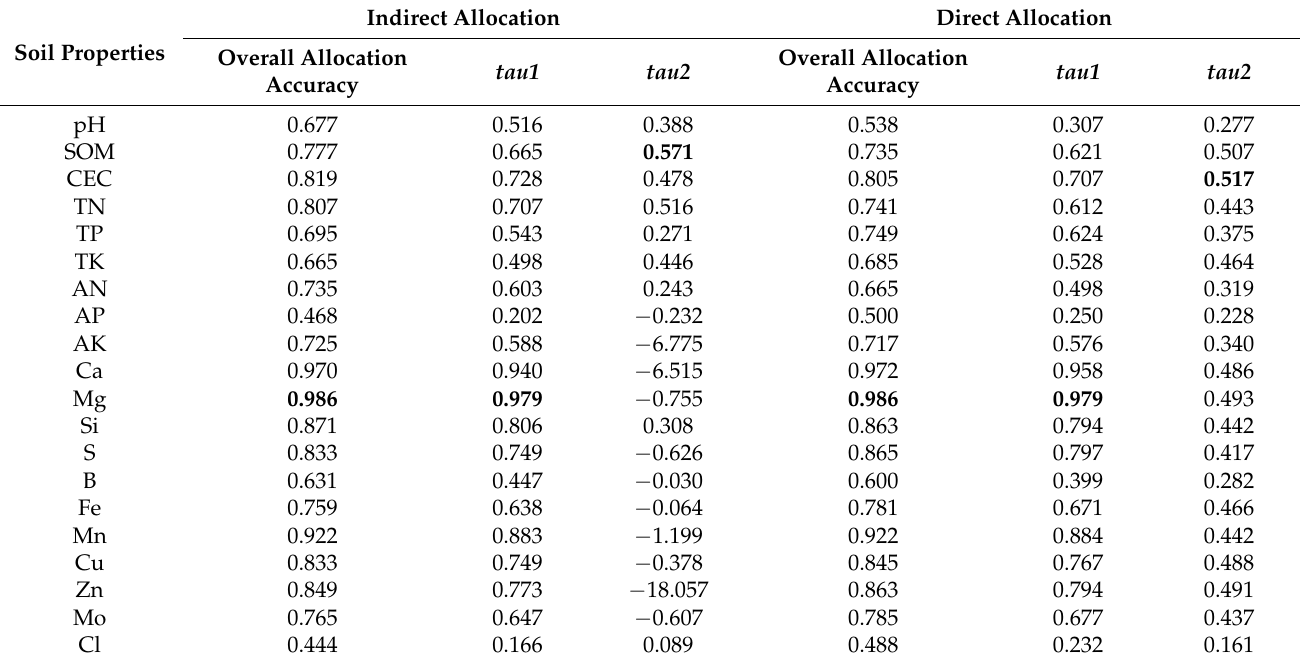
Table 13. Comparison between direct allocation and indirect allocation (three fertility